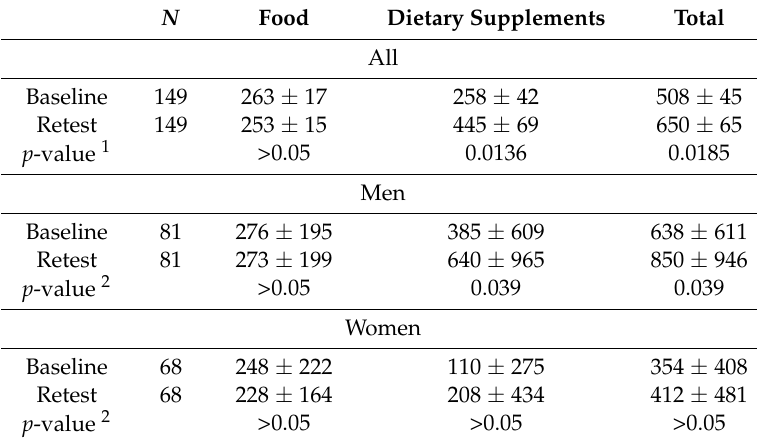
Table 4. Omega-3 intake (mg/day) at the baseline and second test for individuals undergoing two screenings three months apart.